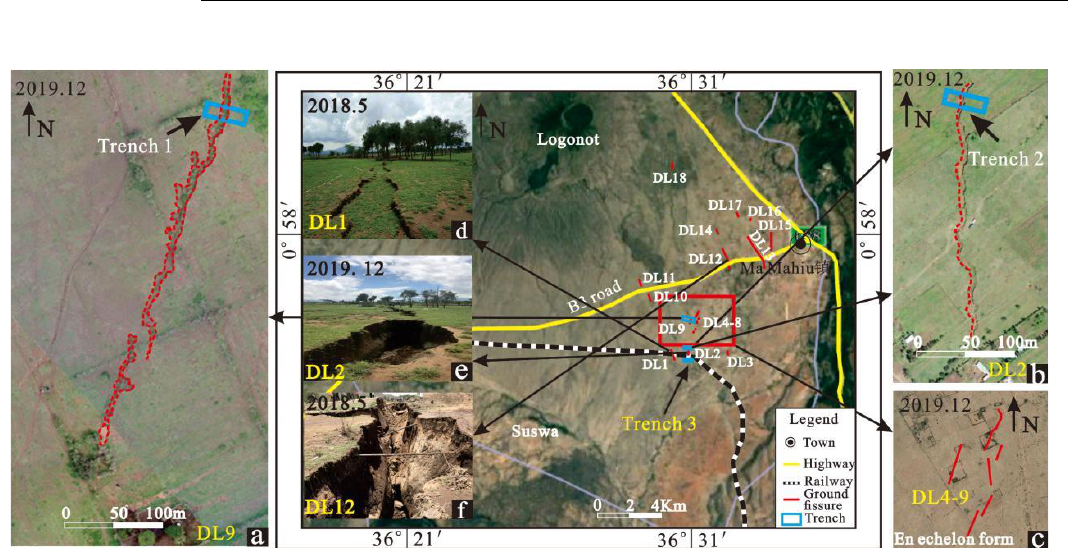
Figure 7. Ground fissure plane distributions. ( a , b ) top view of ground fissures; ( c ) distribution of ground fissures with an en echelon form; ( d – f ) ground fissure surface damage.